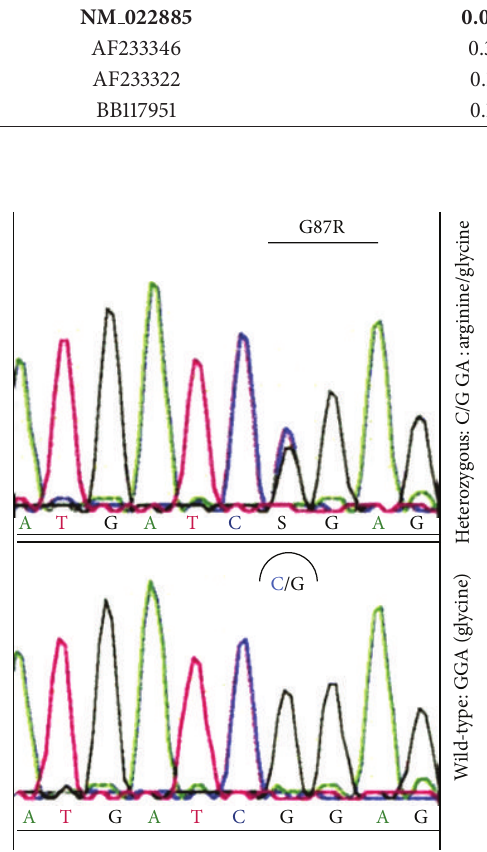
Figure 3: Growth chart of the patient . The solid circles indicate the length measurements. Percentiles are shown on extreme right. The arrows pointing up and down indicate the beginning and the end of the Zn 2+ supplementation therapy.